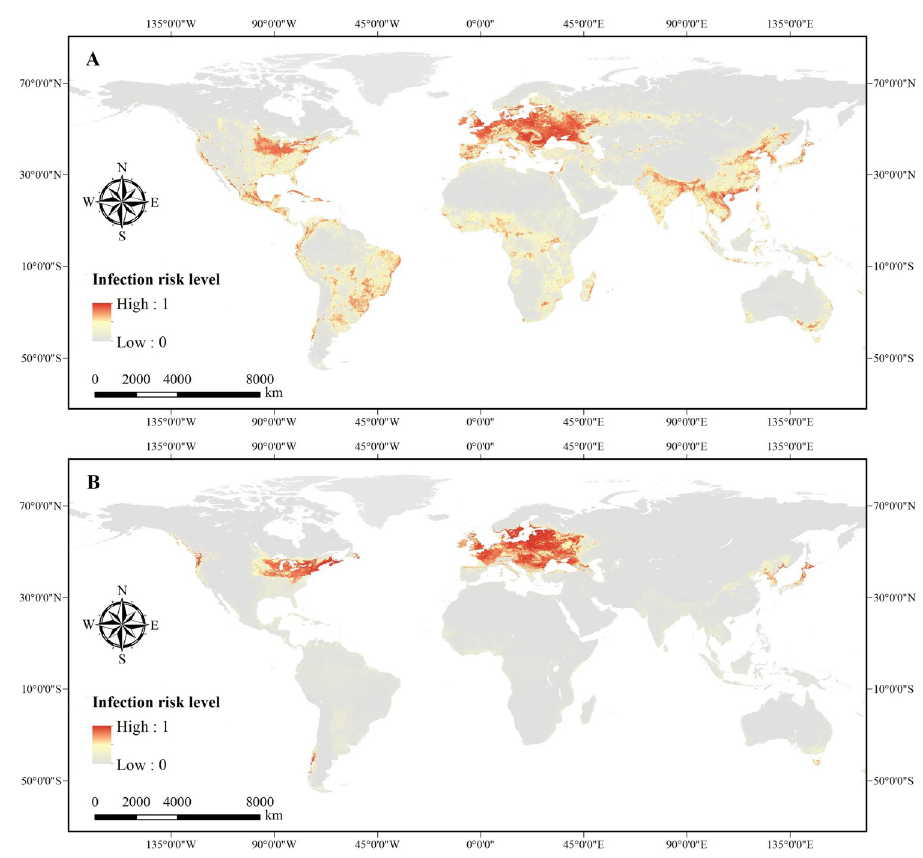
Fig 2. Maps of global spread risk level for African swine fever, ranging from 0 (grey) to 1 (red), which were derived from domestic pigs (A) and wild boars (B)